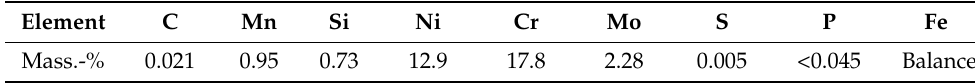
Table 1. Chemical composition of stainless steel 316L powder [30].